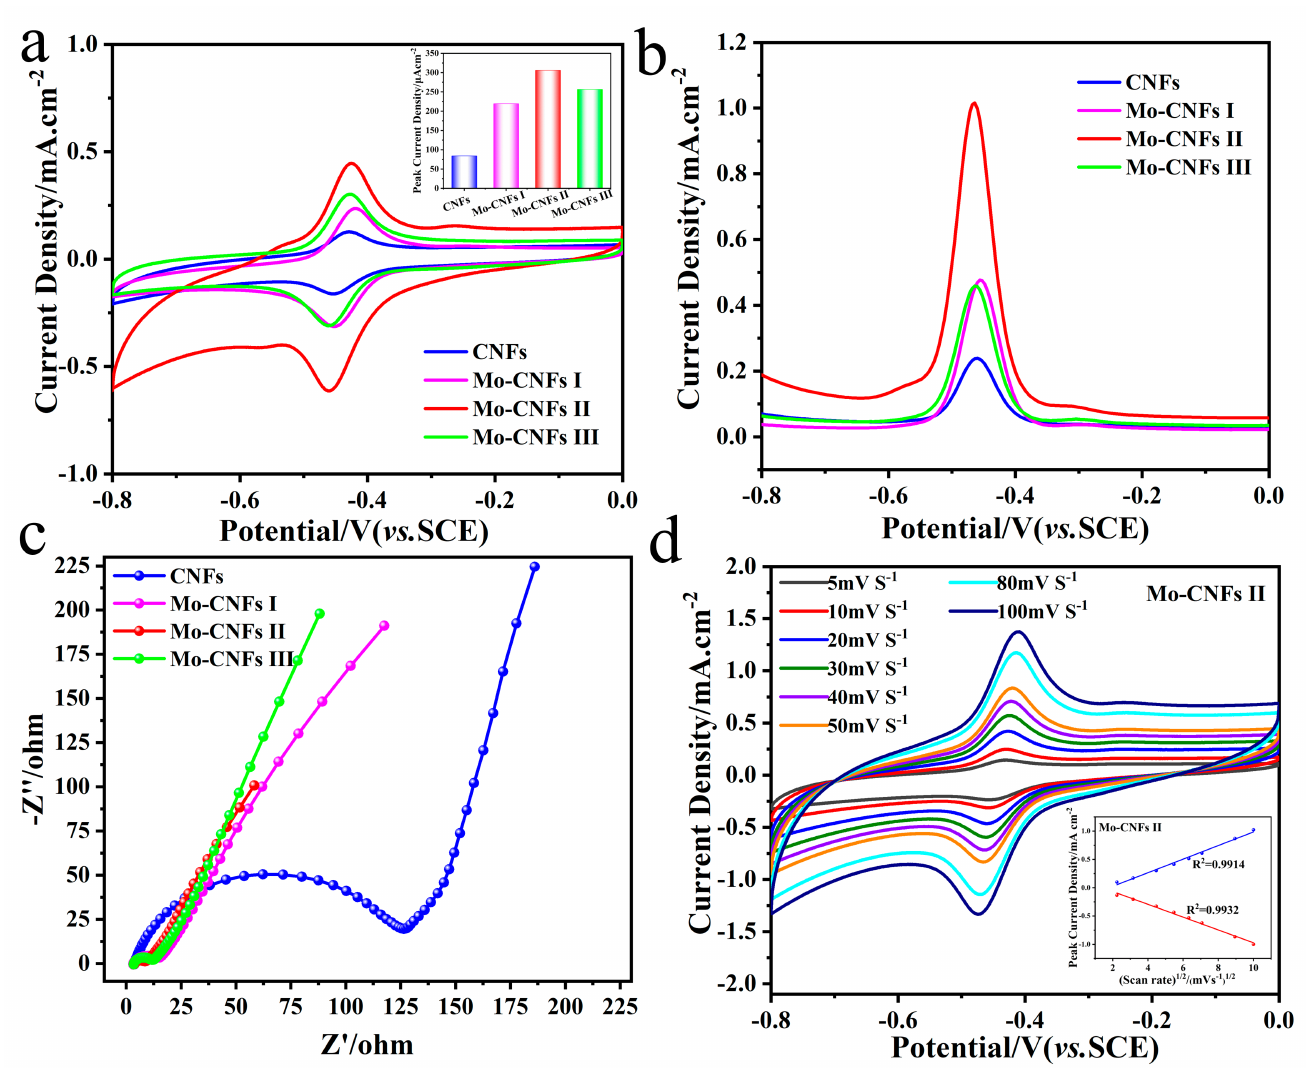
Figure 3. Electrochemical behavior of Mo-CNF and CNF electrodes in 0.1 M PBS containing 2 µ M FMN. ( a ) CVs (30 mV · s − 1 , insert: histogram of redox peak current density). ( b ) DPV curves. ( c ) Nyquist curves. ( d ) CV curves and peak current density at various scan rates of the Mo-CNF II